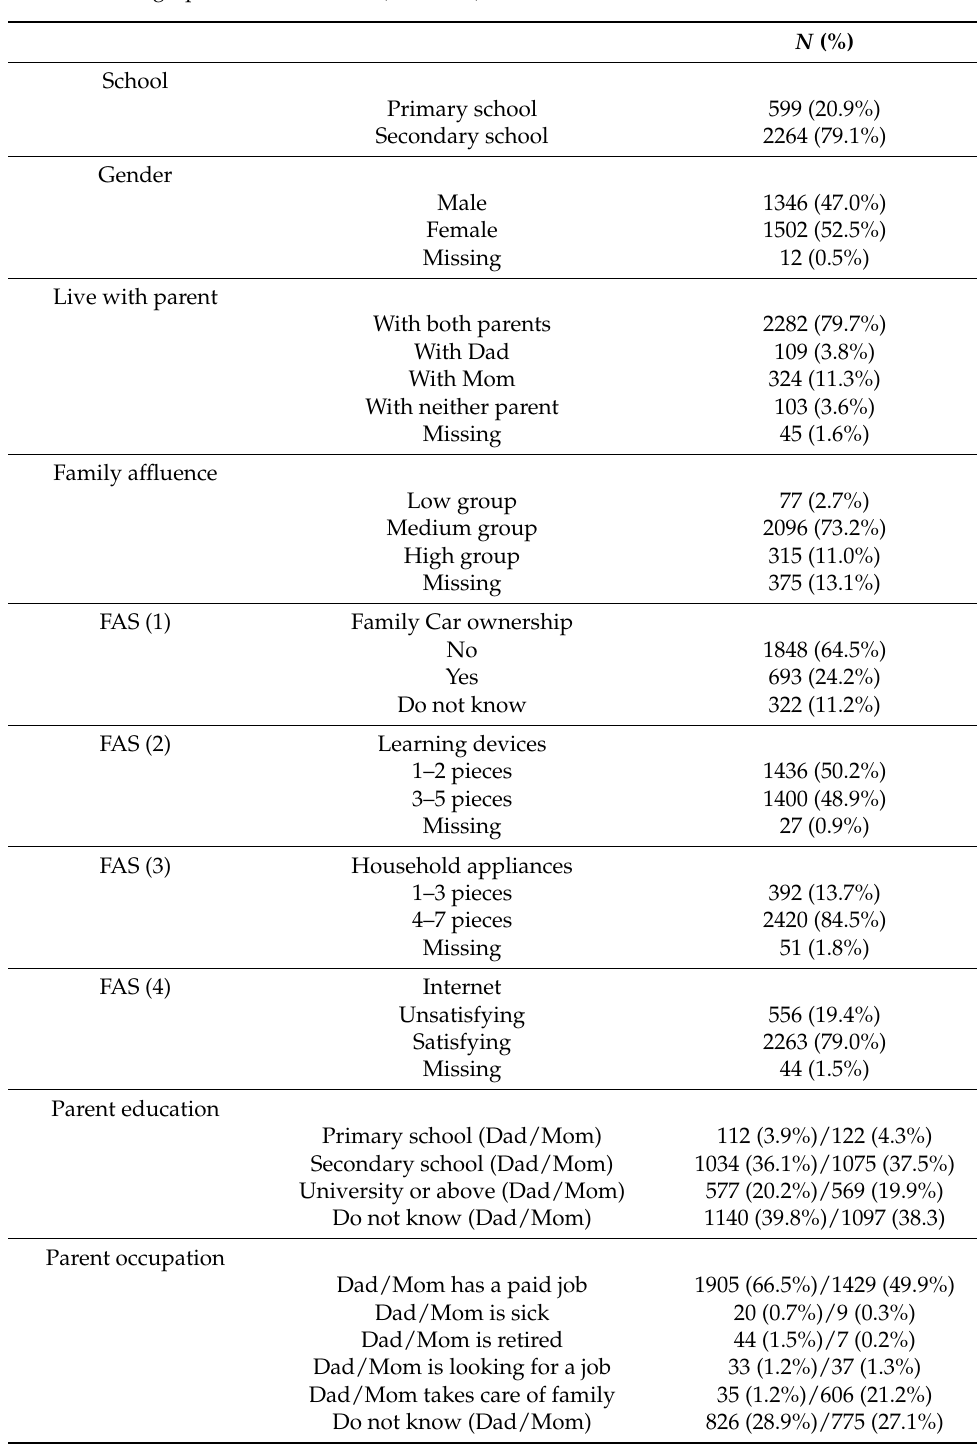
Table 1. Demographic characteristics ( N =